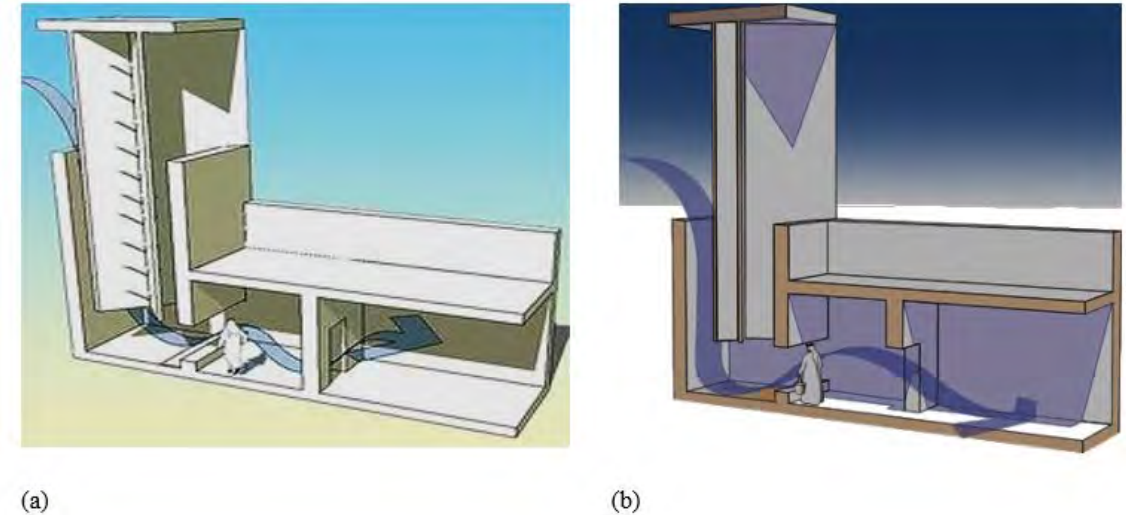
Figure 7. (a) traditional wind tower (Catnaps.org) (b) Air movement through wind tower(Catnaps.org)